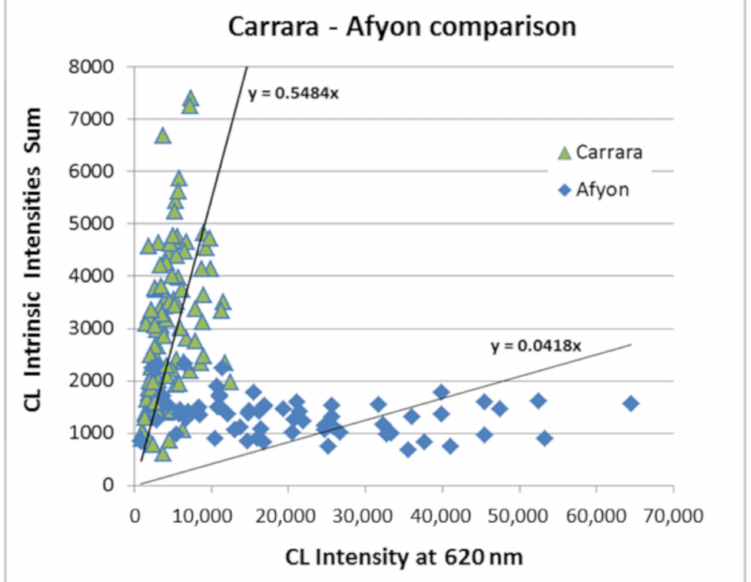
Figure 4. Comparison between Carrara and Afyon quantitative CL data and their respective linear representations.